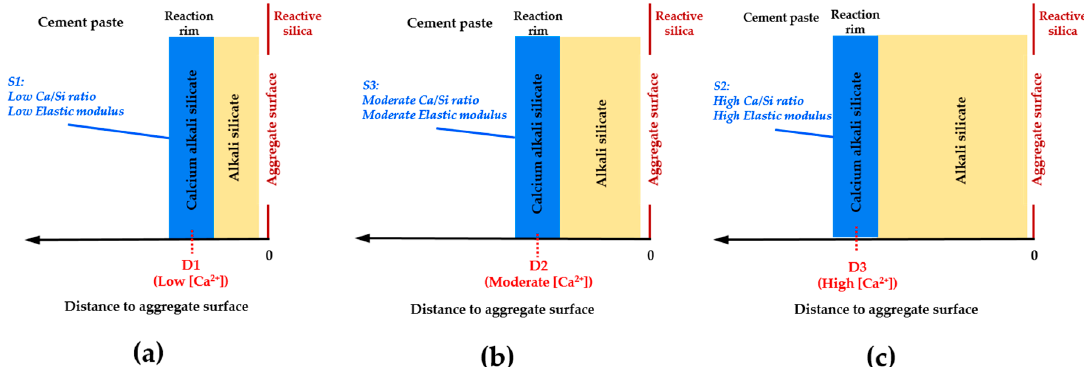
Figure 15. Schematic representation of the reaction rim formed at different locations (D1 < D2 < D3). ( a ) The reaction rim formed at a place close to the aggregate surface; ( b ) the reaction rim formed at a place with a moderate distance to either the cement paste or the aggregate surface; ( c ) the reaction rim formed at a place close to the cement paste.